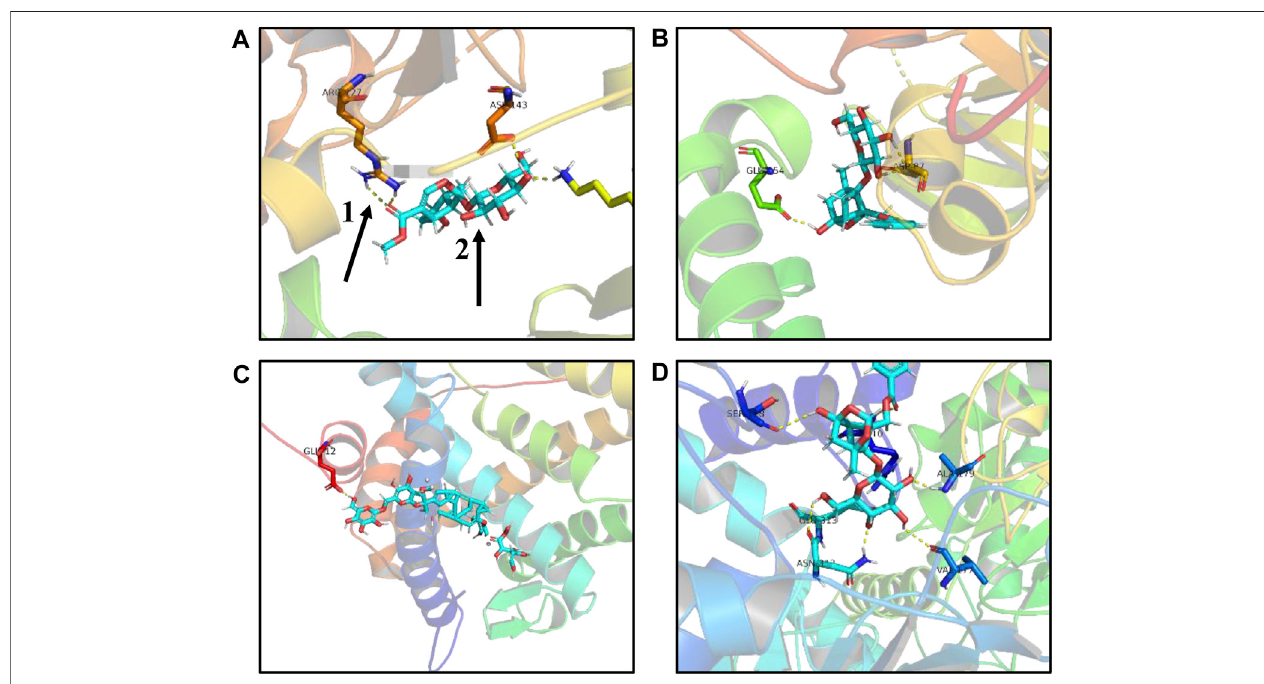
FIGURE9 | Schematic diagram of molecular docking results. (A) Loganin is linked to the SRC active site through two hydrogen bonds to form a complex. (B) Paeoni fl orin is linked to the SRC active site through two hydrogen bonds to form a complex. (C) Ginsenoside Rb1 is linked to the NR3C2 active site through one hydrogenbondtoformacomplex. (D) Paeoni fl orinislinkedtotheGAPDHactivesitethroughthreehydrogenbondstoformacomplex,oneforhydrogenbond,andtwo for small compound ligand.